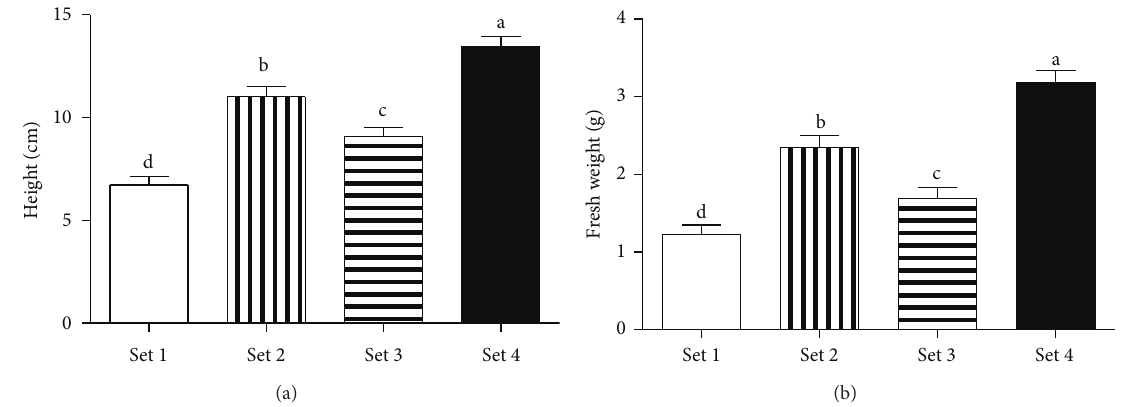
Figure 1: Plant height and fresh weight. (a) Plant height and (b) plant fresh weight. Means with the different letter are significantly different from each other (Tukey-Kramer test, 𝑃 < 0.05